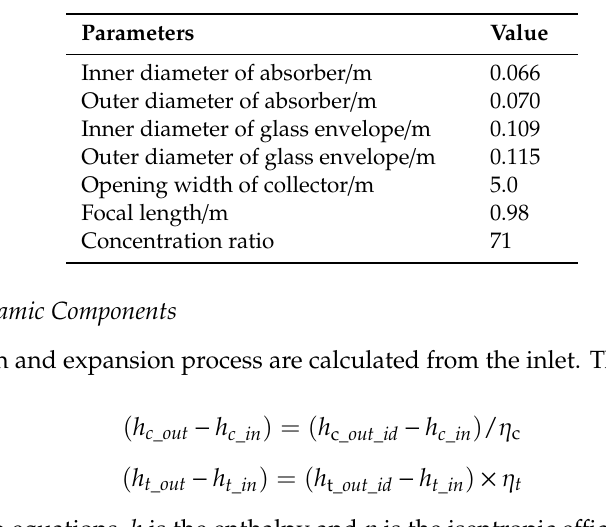
Table 1. Purchasing cost functions for main equipment